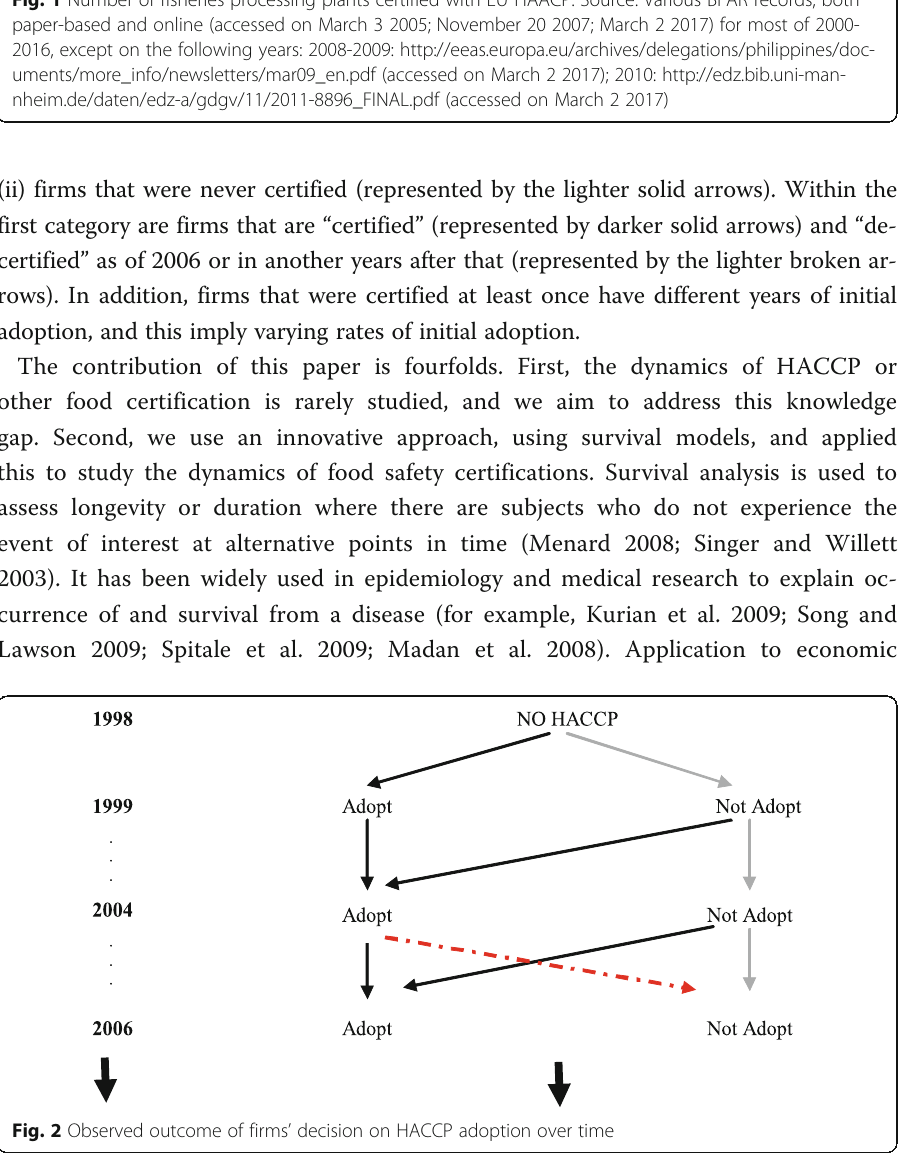
Fig. 1 Number of fisheries processing plants certified with EU HAACP. Source: Various BFAR records, both paper-based and online (accessed on March 3 2005; November 20 2007; March 2 2017) for most of 2000- 2016, except on the following years: 2008-2009: http://eeas.europa.eu/archives/delegations/philippines/doc-